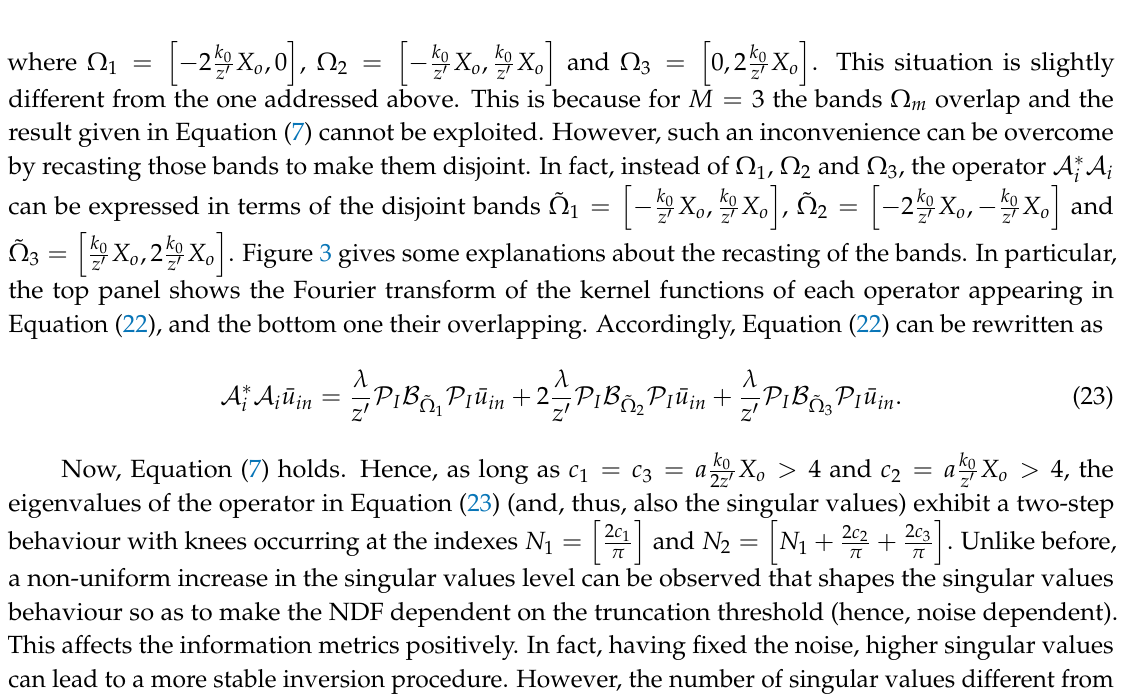
uniformly in O . The Fourier transform of the kernel of operator in Equation (20) is a band-limited X o , 2 k 0 X o ] and consists in 2 M − 3 steps. In particular, each step function with support on [ − 2 k 0 z (cid:48) z (cid:48)